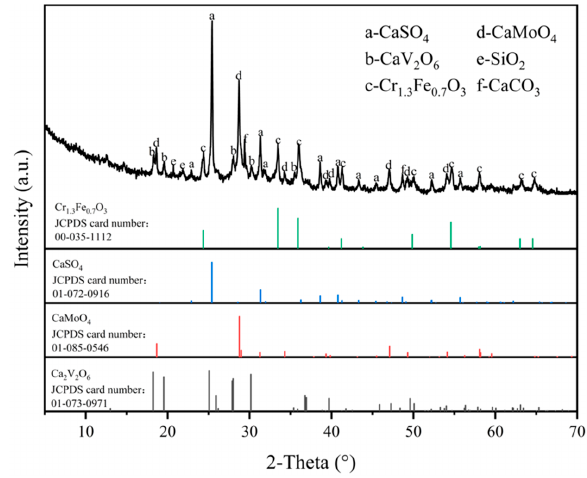
Figure 1. X-ray diffraction ( XRD) patterns of HCVR.